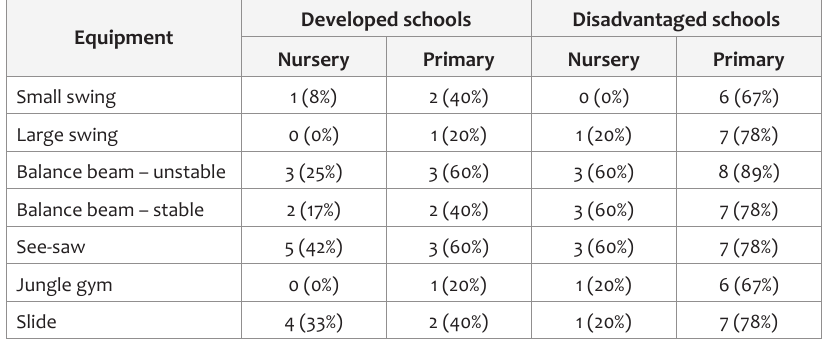
Table 4: Number and percentage of areas with a great shortage of loose equipment